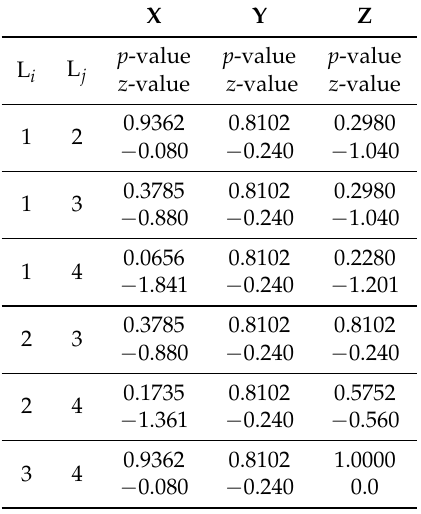
Table 8. Stochastic values for K L in the free decay pendulum test.